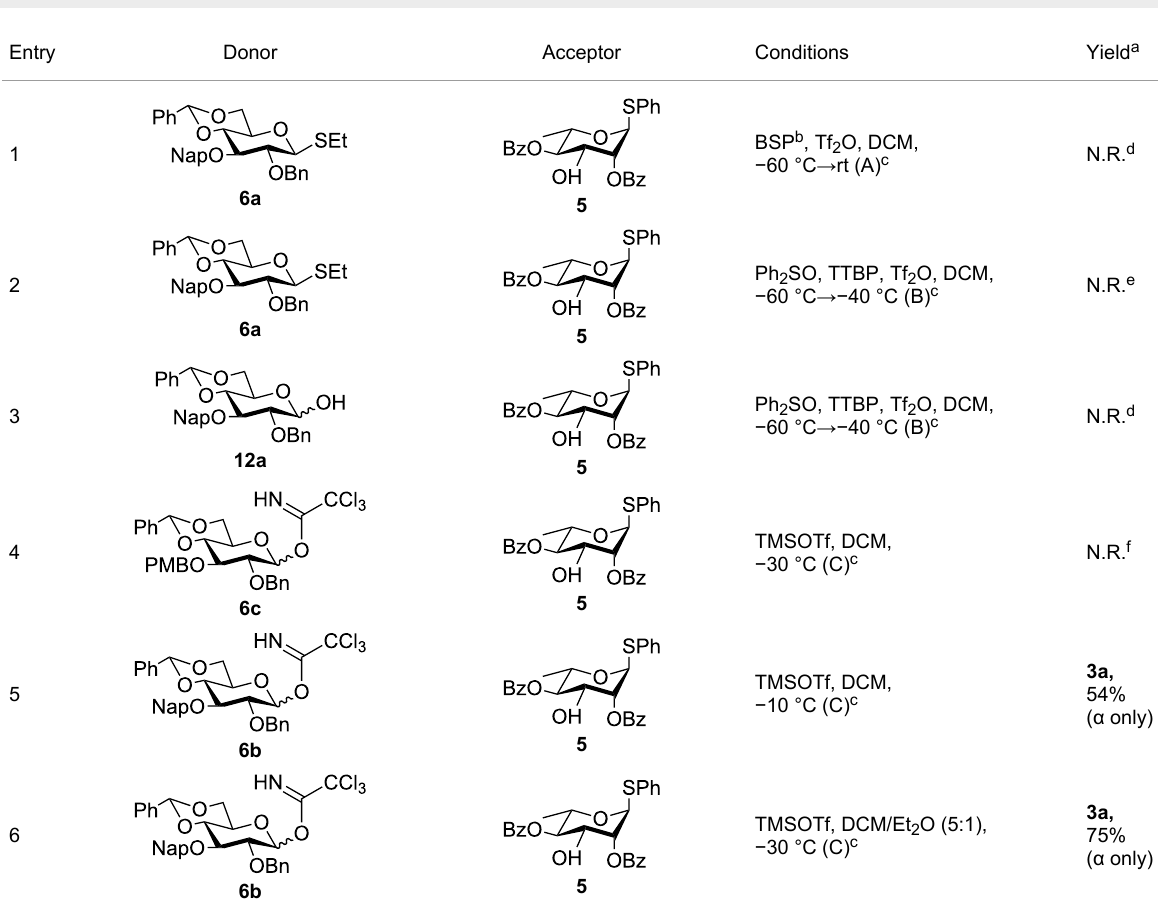
Table 1: Optimization of protocol for the synthesis of disaccharide 3